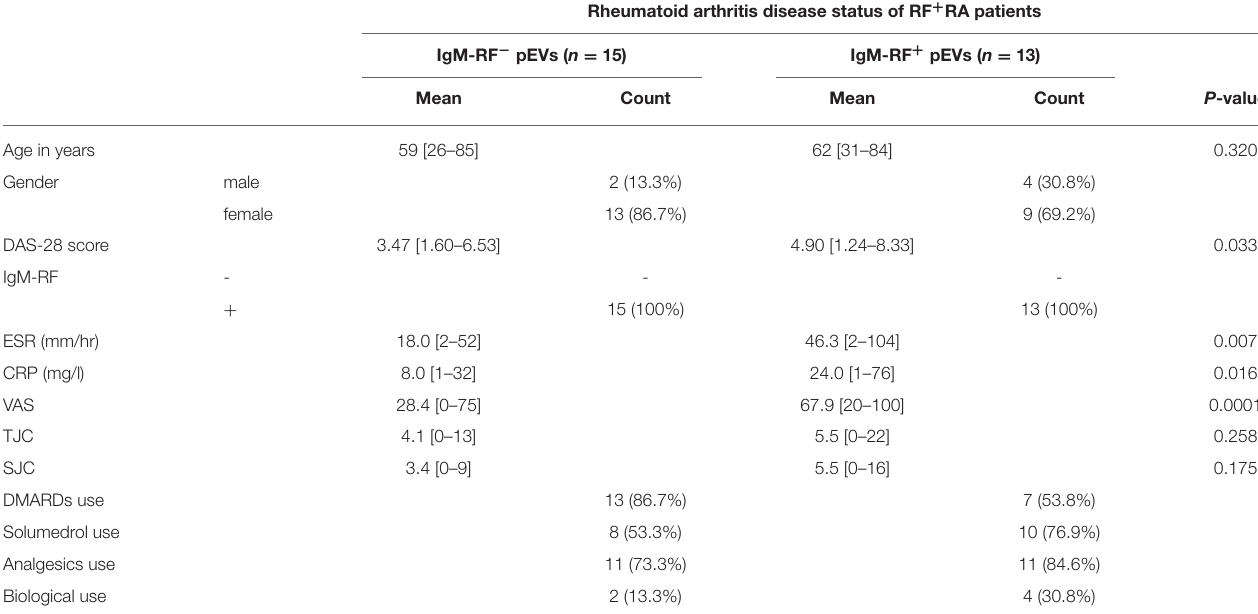
TABLE 2 | Clinical data from RF+RA patients stratified in two groups based on presence of IgM-RF on their pEVs. Rheumatoid arthritis disease status of RF + RA